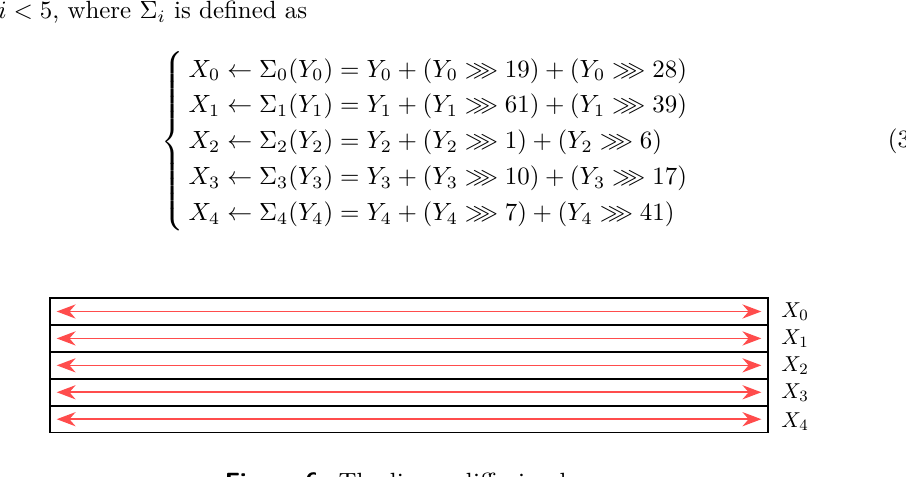
Figure 6: The linear diffusion layer p